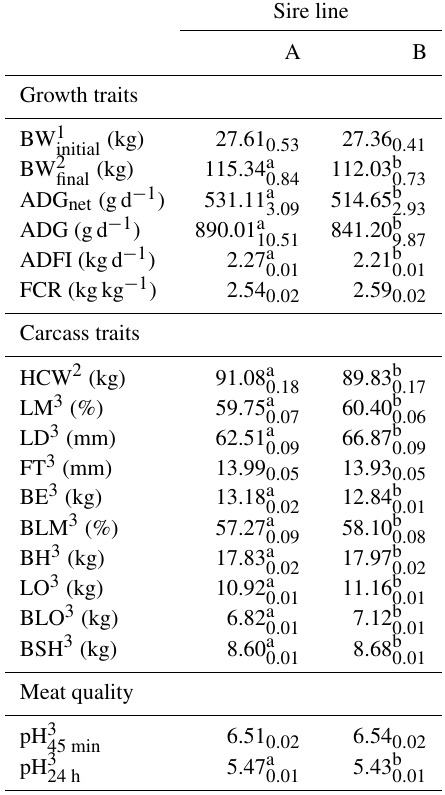
1 Initial age adjusted to 72d. 2 Slaughter age adjusted to 173d. 3 HCW adjusted to 91kg. a–b Values within a row with different superscripts differ